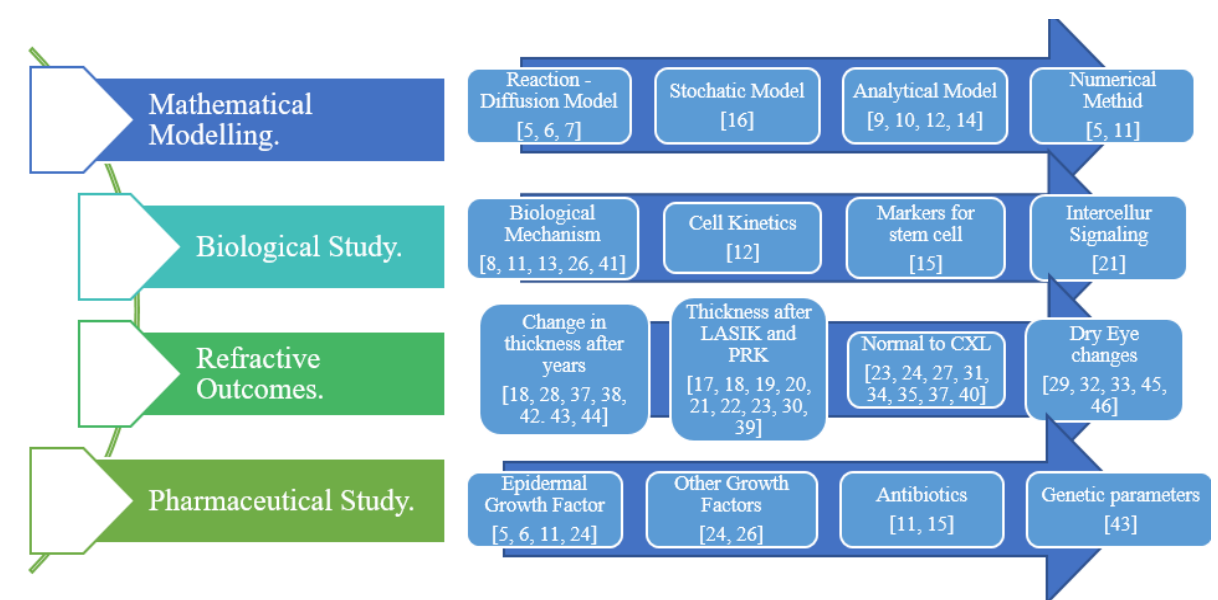
Fig. 1. Research studies regarding the Re-epithelization of cornea.